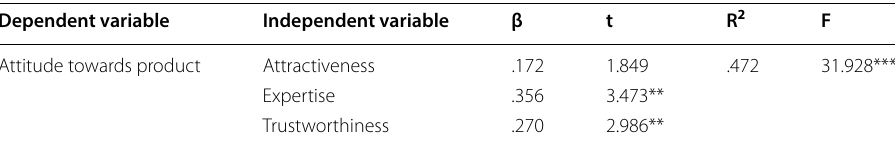
Table 12 Multiple regression result of vlogger’s attributes on attitude towards products— implicit